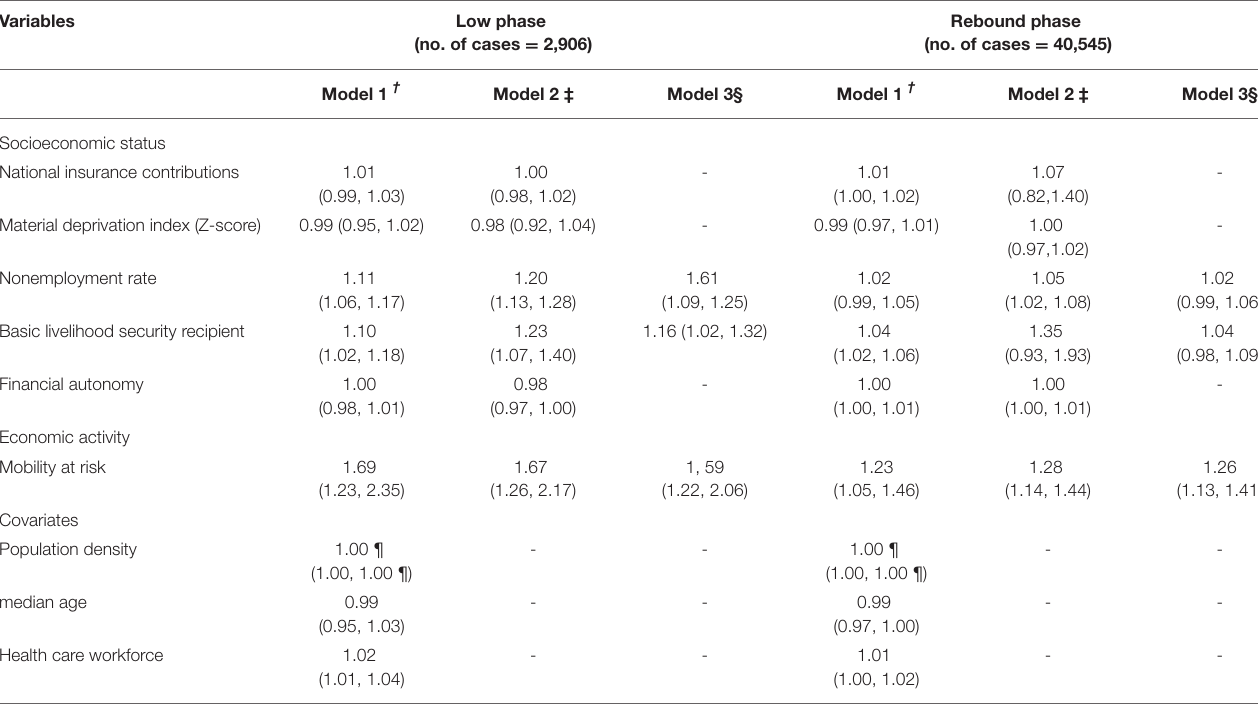
TABLE 3 | Incidence rate ratios for the association between socioeconomic status and economic activity and incidence for COVID-19 over the low and rebound phase in 229 municipalities in Korea.